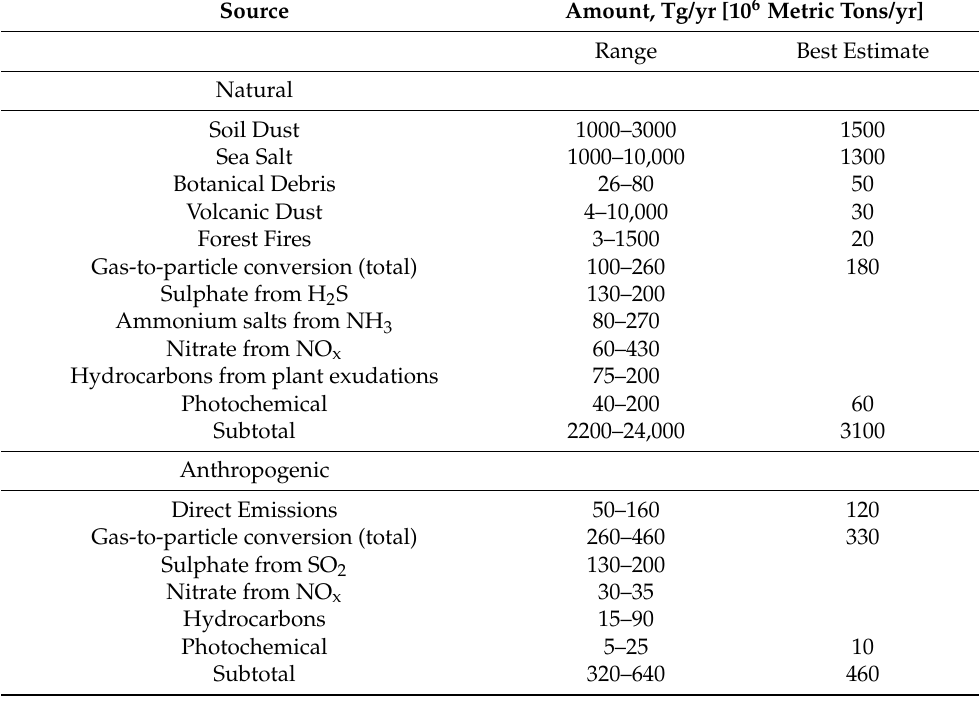
Table 5. Atmospheric aerosol emission sources and estimates. Adapted from [36,37], reproduced with